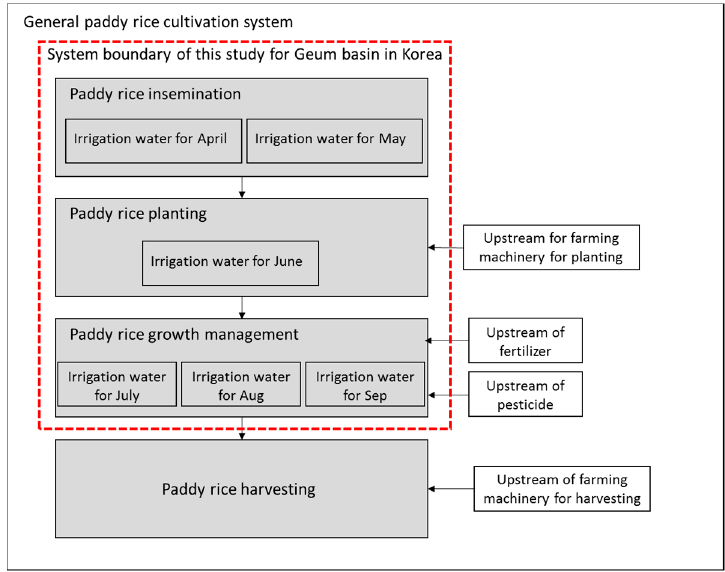
Figure 1. System boundary for the water scarcity footprint of paddy rice production.